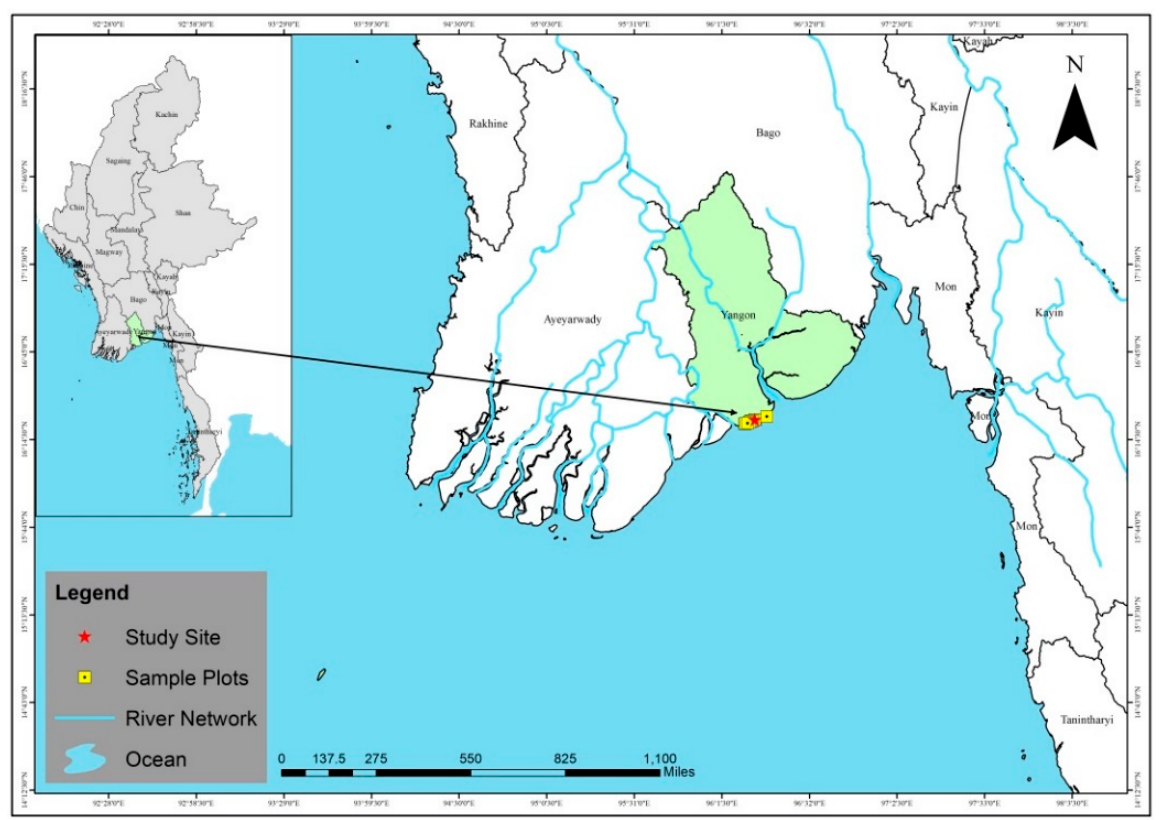
Figure 1. Location of the study site and sampling points in the mangrove stand of Kanhlyashay natural mangrove forest.